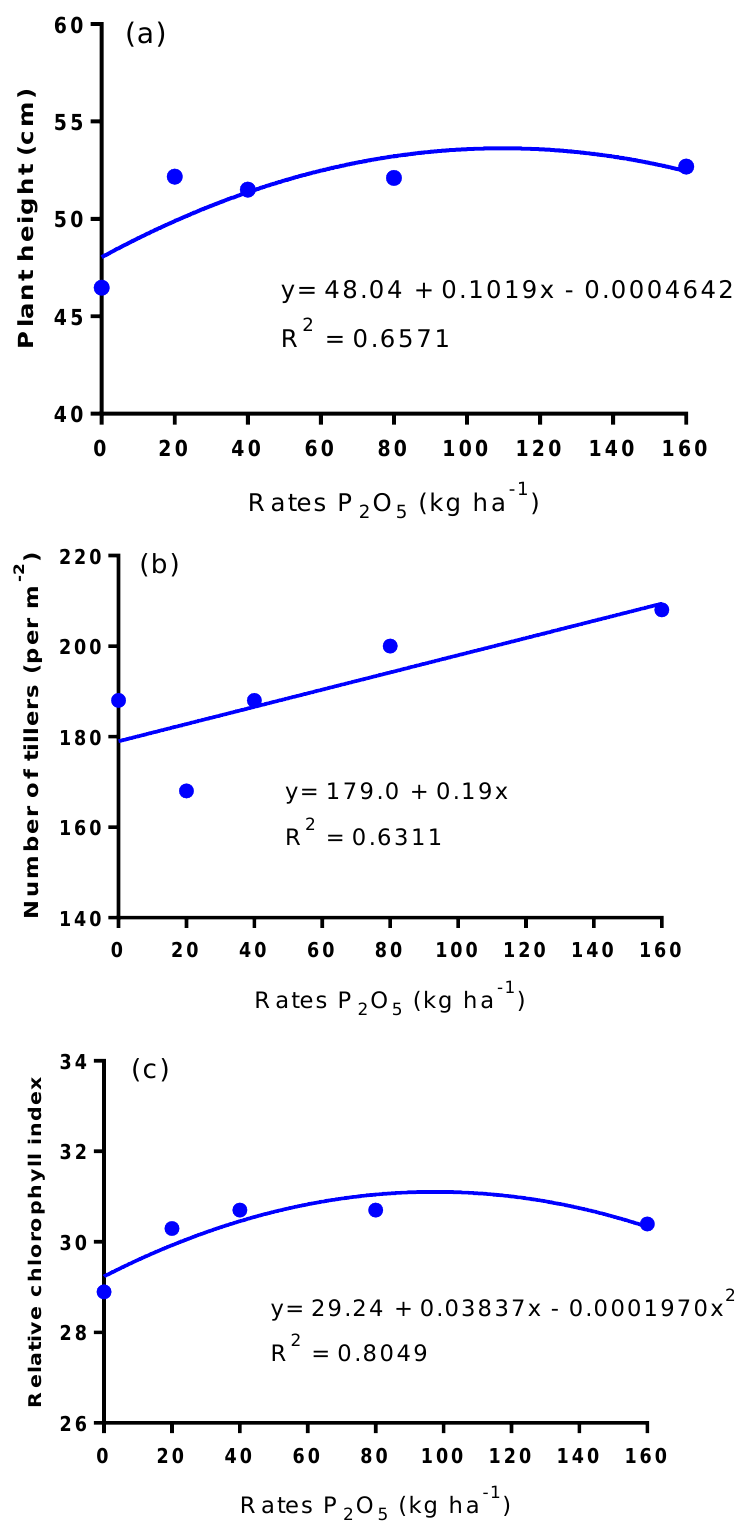
Figure 6. Regression equations for plant height ( a ), number of tillers per square meter ( b ), relative chlorophyll index ( c ) of Mavuno grass as function of phosphorus sources and rates in the presence and absence of polymers in dystrophic